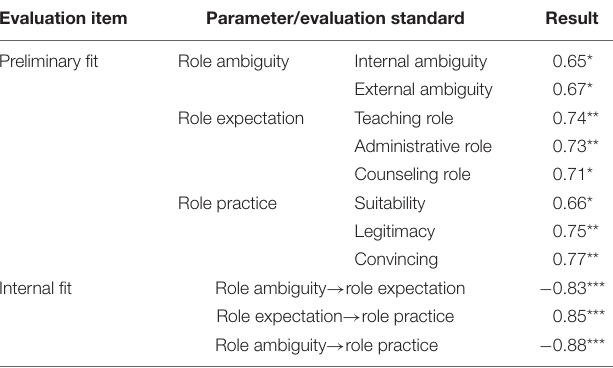
TABLE 1 | Overall results of linear structural model